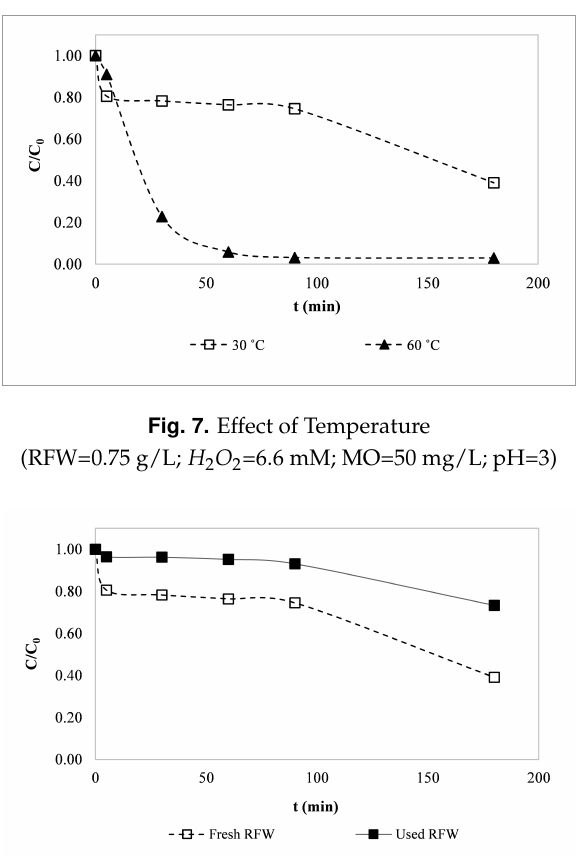
Fig. 8. Reusability of RFW